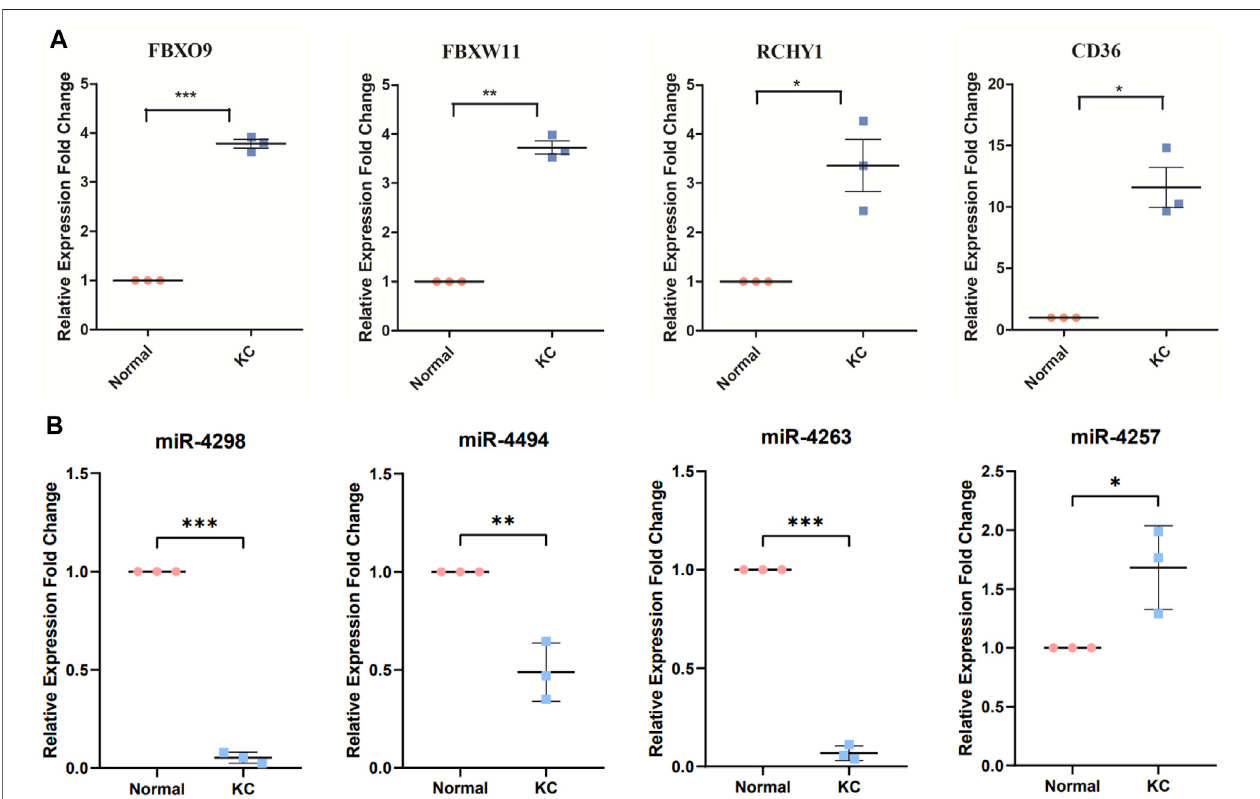
FIGURE 7 | Validation of core-predicted miRNAs using qRT-PCR. (A) Q-PCR showed critical genes FBXO9, FBXW11, RCHY1, and CD36 mRNA upregulated in KC. (B) Figure showed miR-4298, miR-4494, and miR-4263 downregulated in KC, while miR-4257 was upregulated in KC. Note: Pink represents normal samples and blue represents KC samples. * p < 0.05, ** p < 0.01, and *** p <